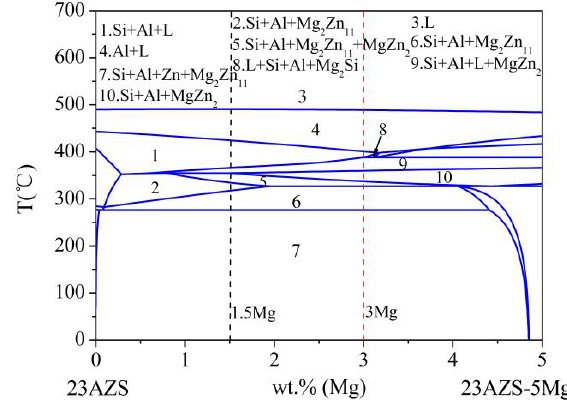
Figure 4. Vertical section phase diagram of 23AlZn0.3Si and 23AlZn0.3Si5Mg (wt %).